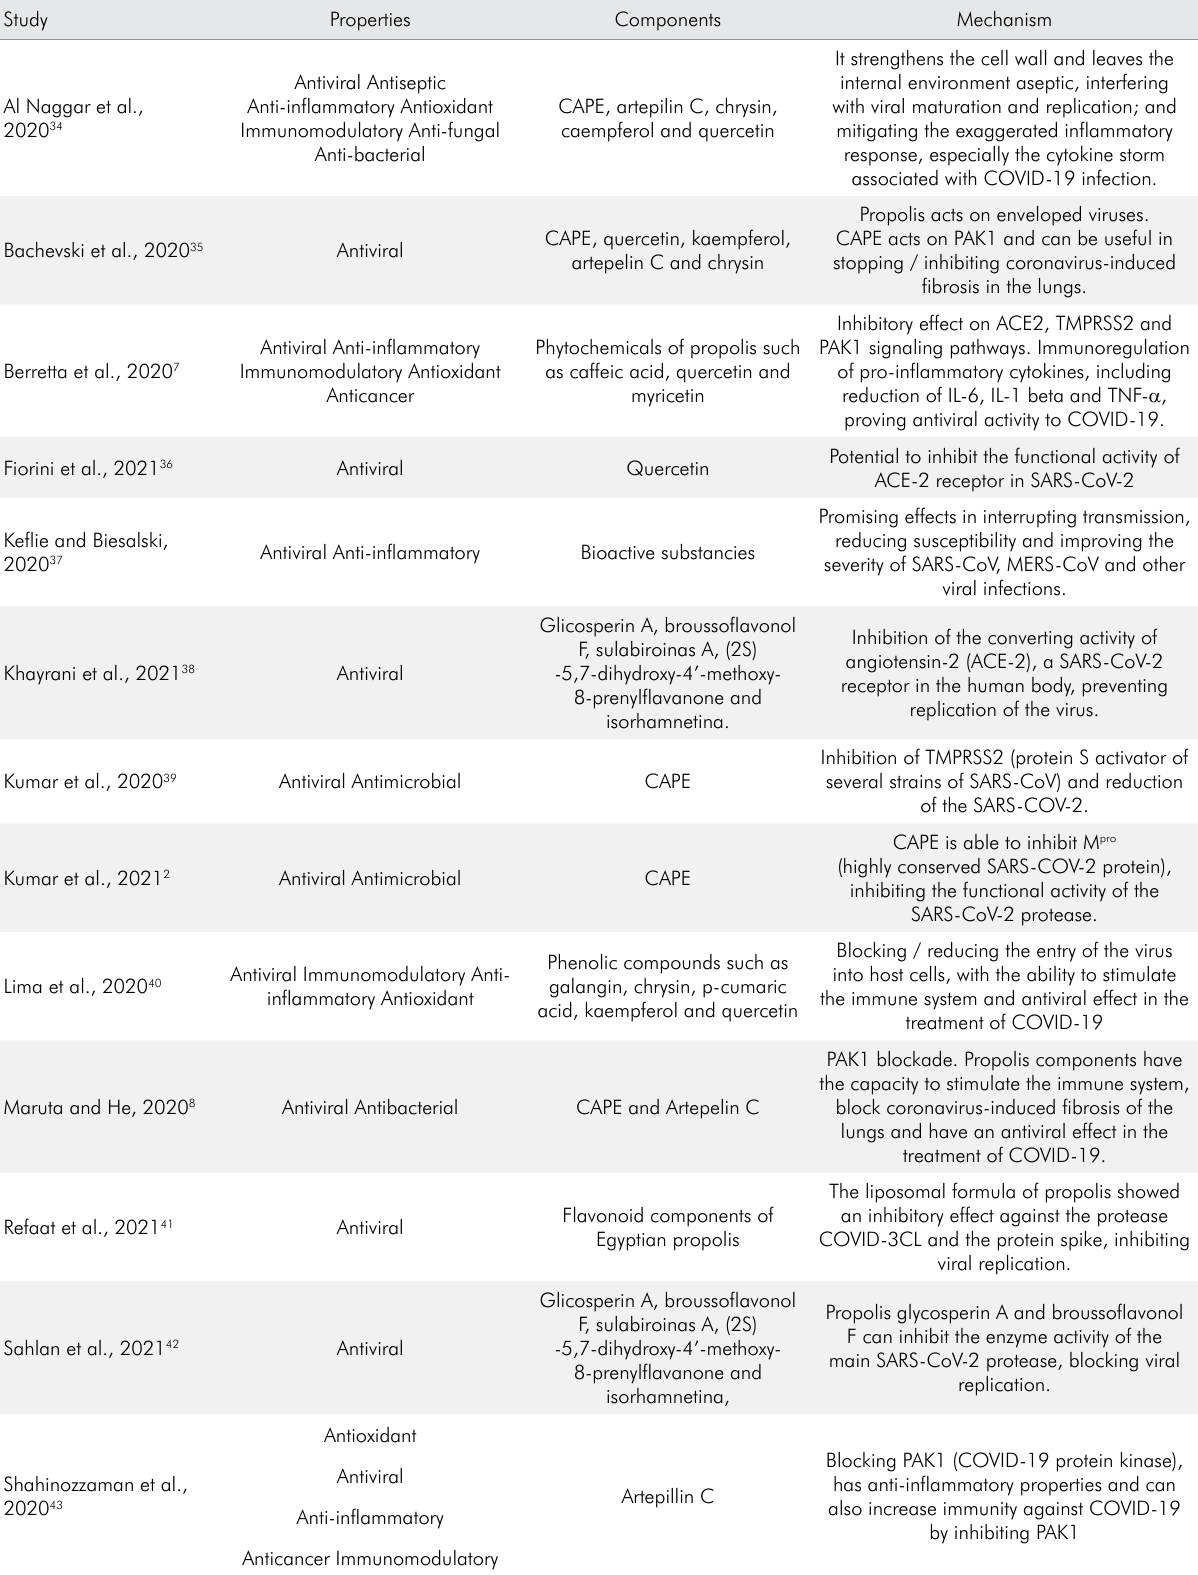
Table 2. Properties and mechanisms of Propolis components against SARS-CoV-2 and